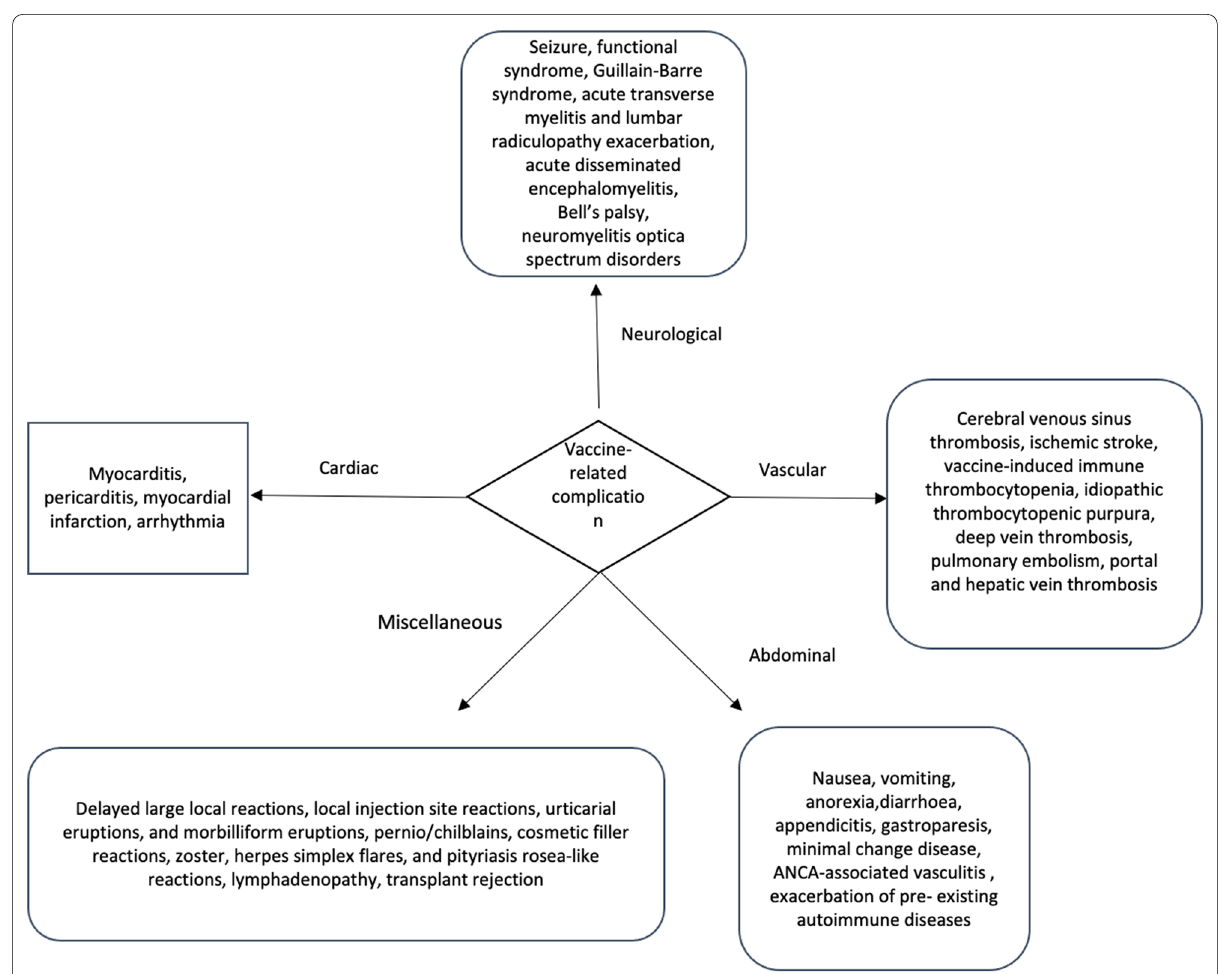
Fig. 1 Vaccine-related side effects in different